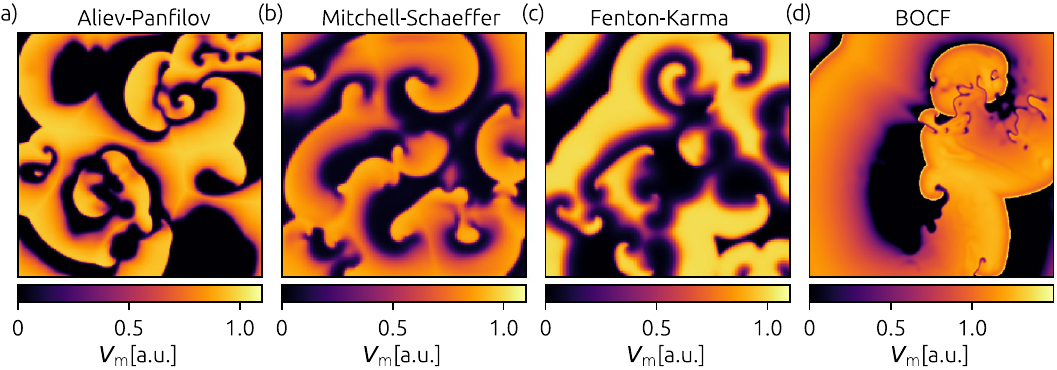
Figure 1. Exemplary snapshots of the membrane voltage V m during episodes of spiral wave chaos are shown for the investigated cell models: the Aliev-Panfilov model AP ( a ), the Mitchell–Schaeffer model MS ( b ), the three- variable Fenton-Karma model FK ( c ), and the Bueno-Orovio-Cherry-Fenton model BOCF ( d ),